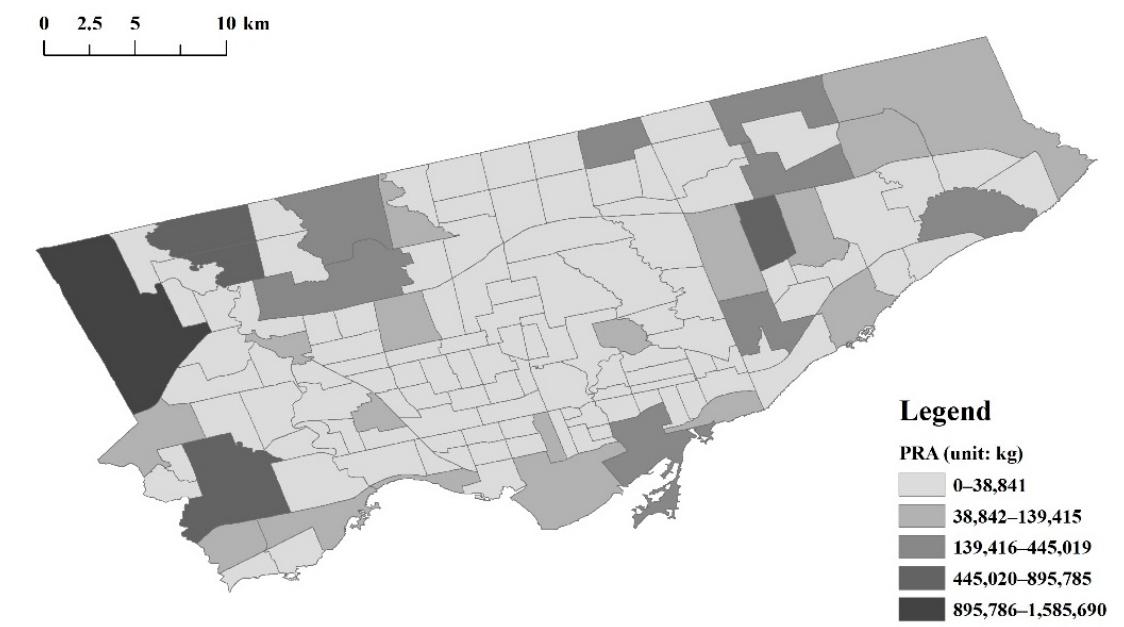
Figure A13. Distribution of pollutants released into the air (PRA).